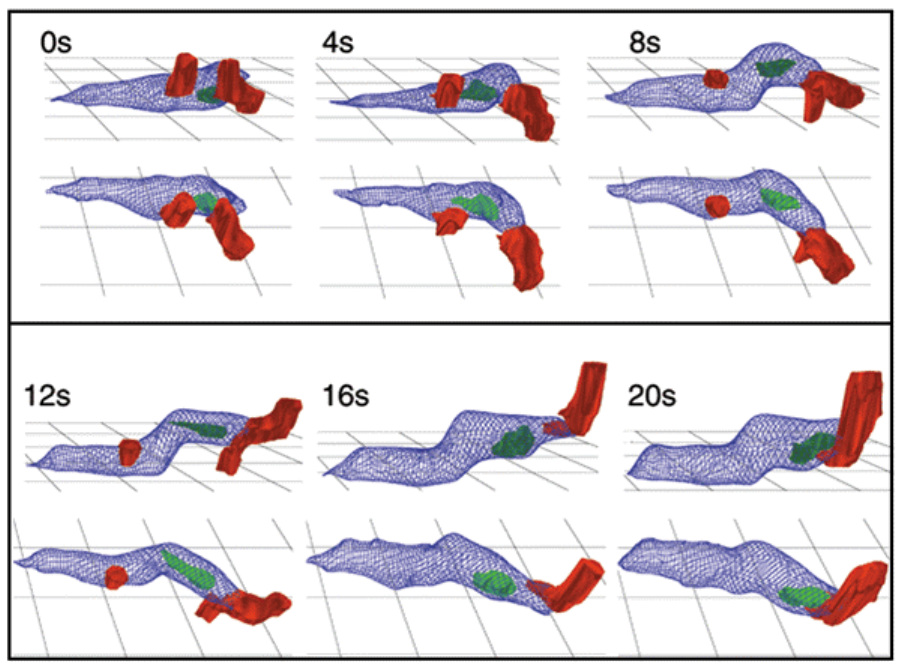
FIGURE 3 . 3D-DIAS reconstructions of a wild type Dictyostelium amoeba crawling up a spatial gradient of the chemoattractant cAMP. The cell body is represented as a blue faceted transparent cage, the nucleus is represented as a nontransparent green image, and pseudopods are represented in a nontransparent red image. Time is in second(s). Reconstructions are viewed from two angles at each time point (see [12] for